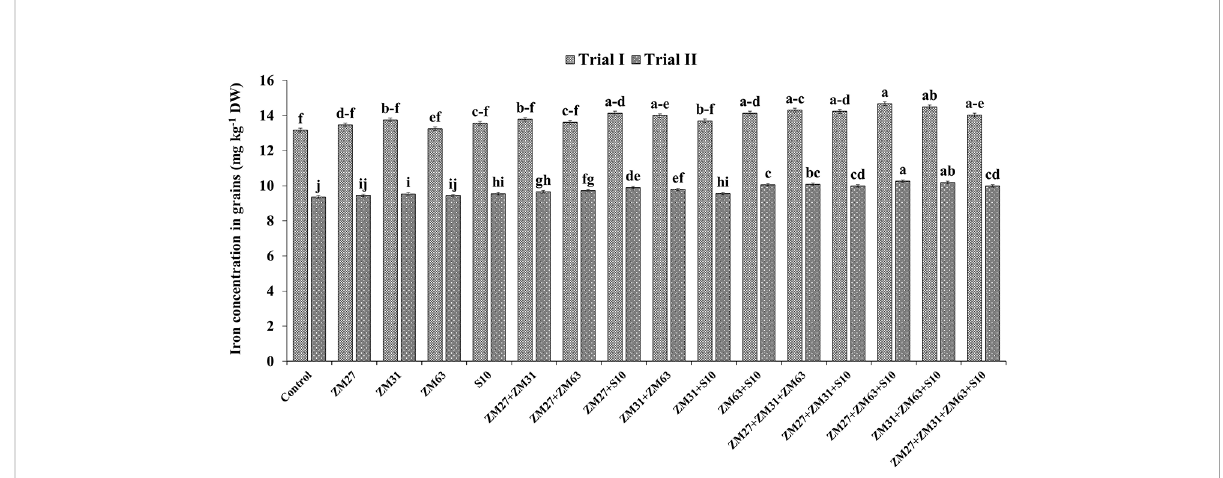
FIGURE 4 Effect of PGPR inoculation on grain iron contents in maize in the pot trial. The bars with different letters are signi fi cantly different at p ≤